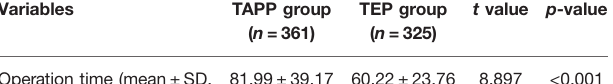
TABLE 2 | Perioperative clinical data of patients in the TAPP group vs. TEP group.